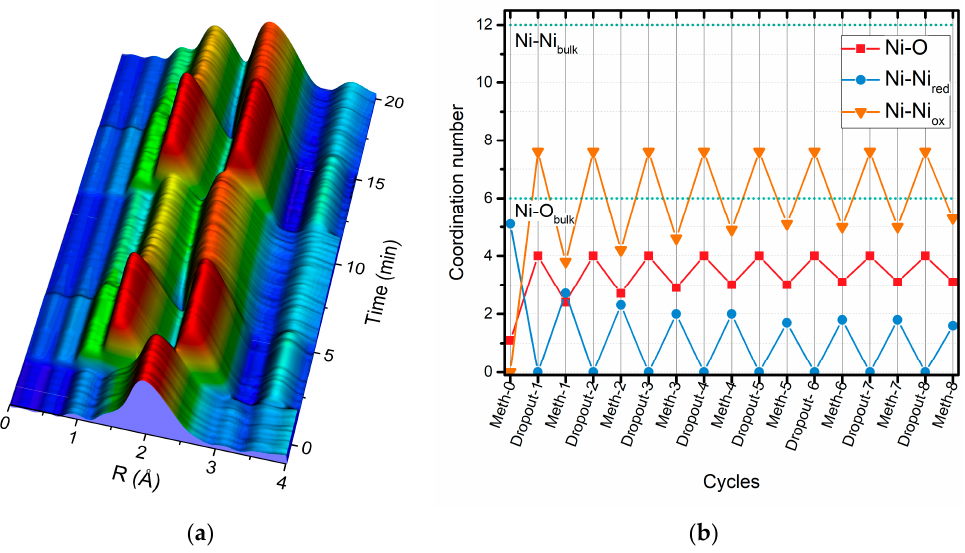
Figure 8. ( a ) FT EXAFS data ( k : 3–11 Å − 1 ; k 2 -weighted) during repeated 300-s H 2 dropouts; ( b ) Results of the EXAFS fitting analysis during the 300-s modulation. The final spectra of each sequence were analyzed. The coordination numbers of neighboring atoms are presented: Ni-O and Ni-O-Ni correspond to O and Ni coordination numbers, respectively, in oxidized nickel and Ni-Ni to the coordination number of the first nickel shell in reduced nickel.